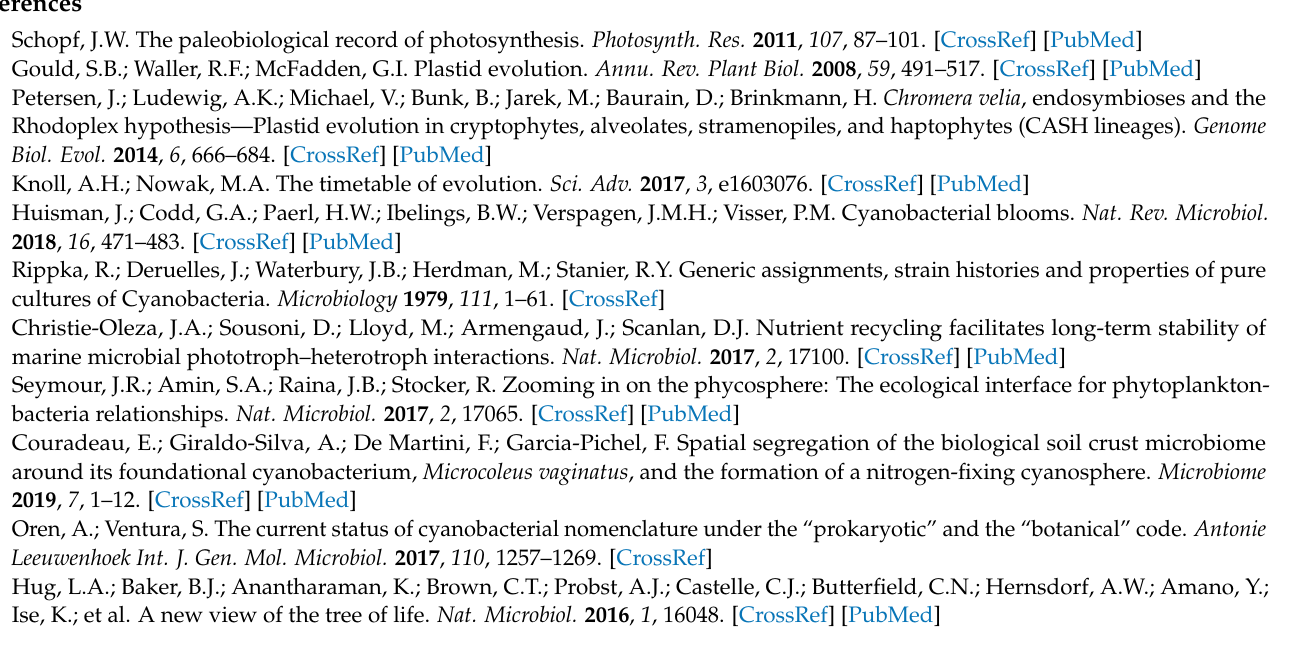
Table S3: Analysis of RpoB protein sequences from metagenomic binning and comparison with taxonomic marker lineage affiliation. Table S4: Result of BLASTN-based taxonomy mining and comparison with taxonomic marker lineage affiliation. Table S5: Result of BLASTN-based taxonomy mining and comparison with taxonomic marker lineage affiliation. Table S6: Comparison of the phylogenetic affiliation of 213 Cyanobacteria with the NCBI taxonomy (see MLSA-tree, Figure S2). Figure S1: Scanning electron microscopy of three non-axenic cyanobacteria. Figure S2: MLSA- Phylogeny of 213 Genome-sequenced Cyanobacteria. Figure S3: MLSA-Phylogeny of 70